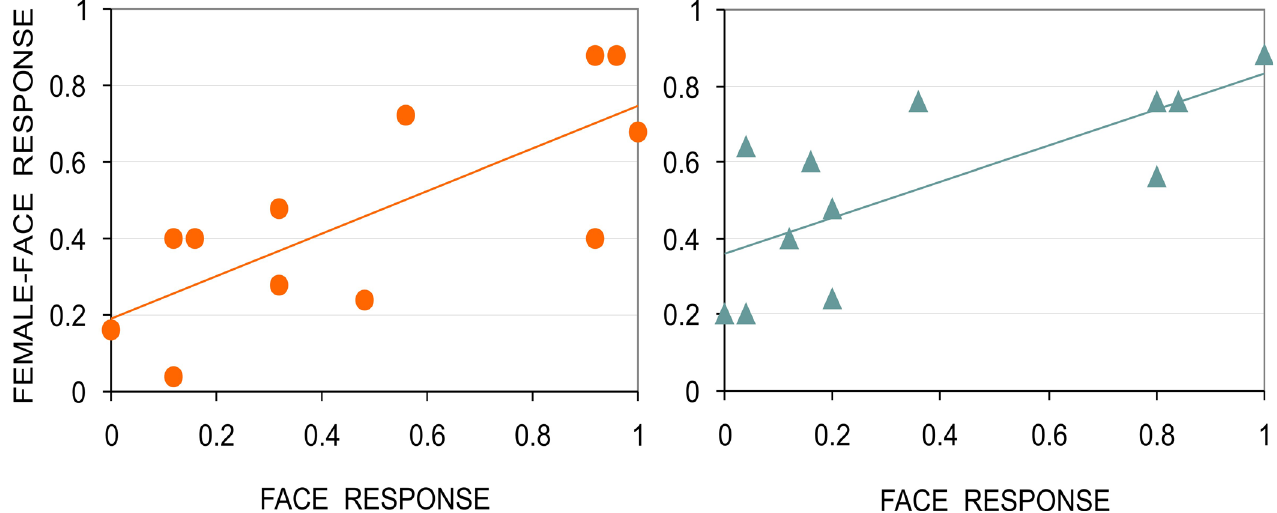
Fig 4. Face resemblance and face gender. Close relationship occurs between gender specific impression (as proportion of female-face responses) and face resemblance (as proportion of face responses) for female, left panel, and male, right panel, participants. In both female and male perceivers, face resemblance positively correlates with female-face impression; trendlines are shown for illustrative purposes only.